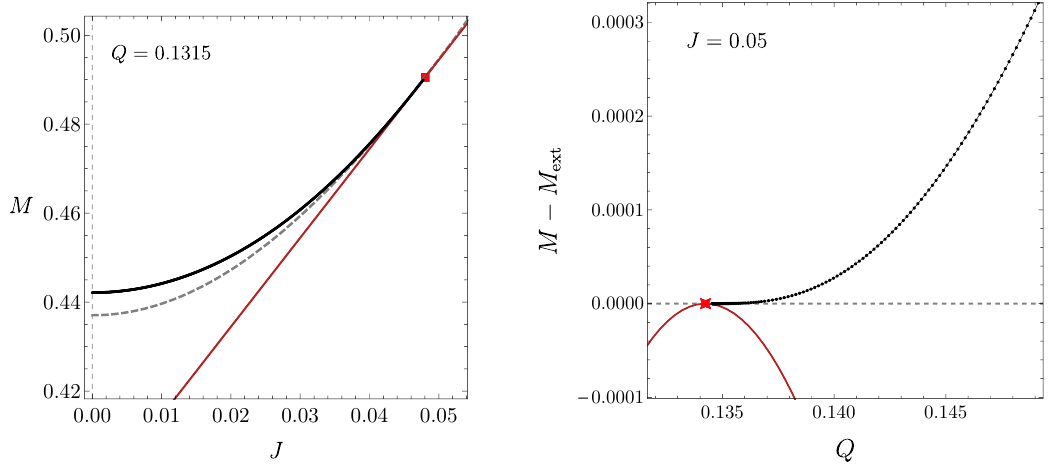
Figure 4 . Left : the line of solutions showing the onset of the superradiance for the CLP black holes at constant charge Q = 0 : 1315 (black points). These solutions extend arbitrarily close to the supersymmetric black holes (red square), with the temperature asymptotically approaching T = 0. The grey dashed line shows the extremality, and the red bold line shows the BPS bound M = 3 Q + 2 J . Right : the di(cid:11)erence M (cid:0) M ext against the charge Q , for black holes with (cid:12)xed J = 0 : 05 and " H = 10 (cid:0) 4 (black data points), where M ext is mass of the extremal CLP black hole with the same Q . Red solid line is the BPS bound, and the red star shows the Gutowski-Reall